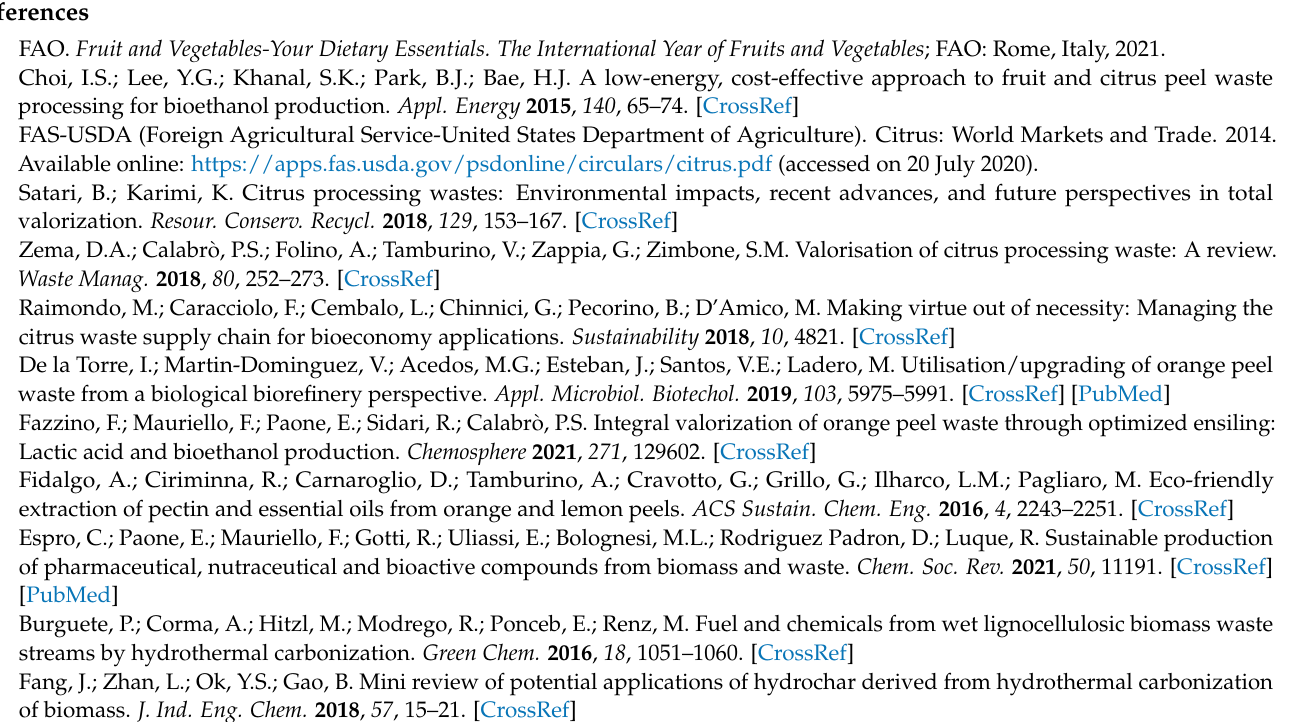
samples. Figure S3. X-ray diffrattograms of the hydrochar obtained at different temperature after (a) 180 min of reaction time and (b) 300 min of reaction time. Figure S4. FT-IR analysis of the hydrochar samples at (a) 60 min of reaction time; (b) 180 min of reaction time; (c) 300 min of reaction time.